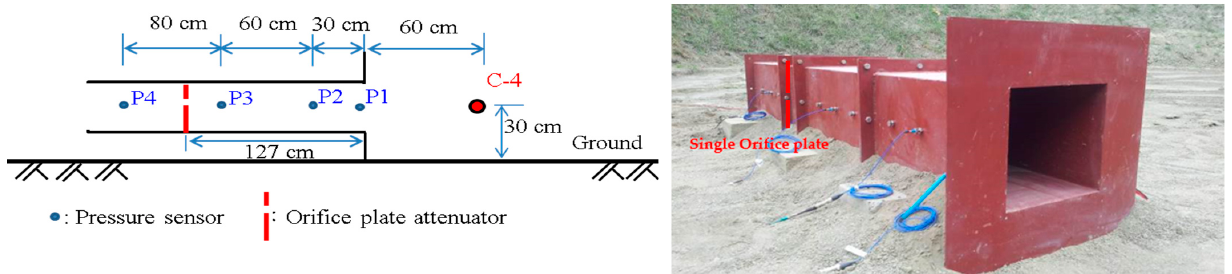
Figure 2. Experimental configuration and specimen of linear tunnel with single-pressure relief orifice plate.